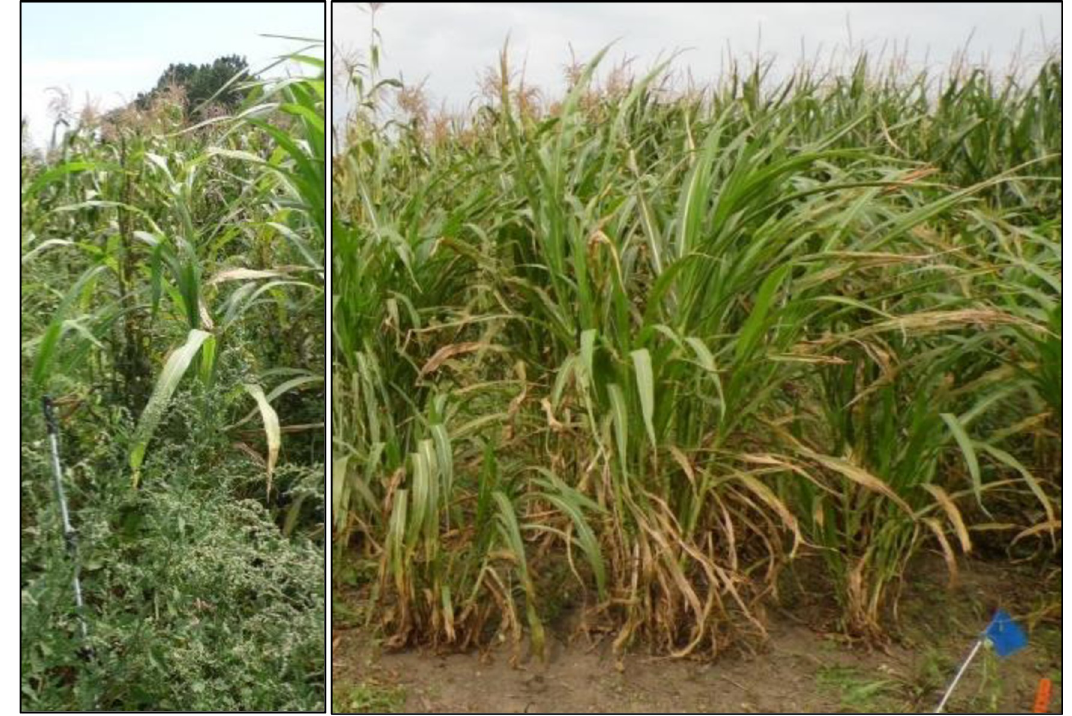
Fig 2. Teosinte ( Zea mays ssp . parviglumis ) in weedy and weed-free environments, late season. Common lambsquarters ( Chenopodium album ) can be seen in the foreground (left).